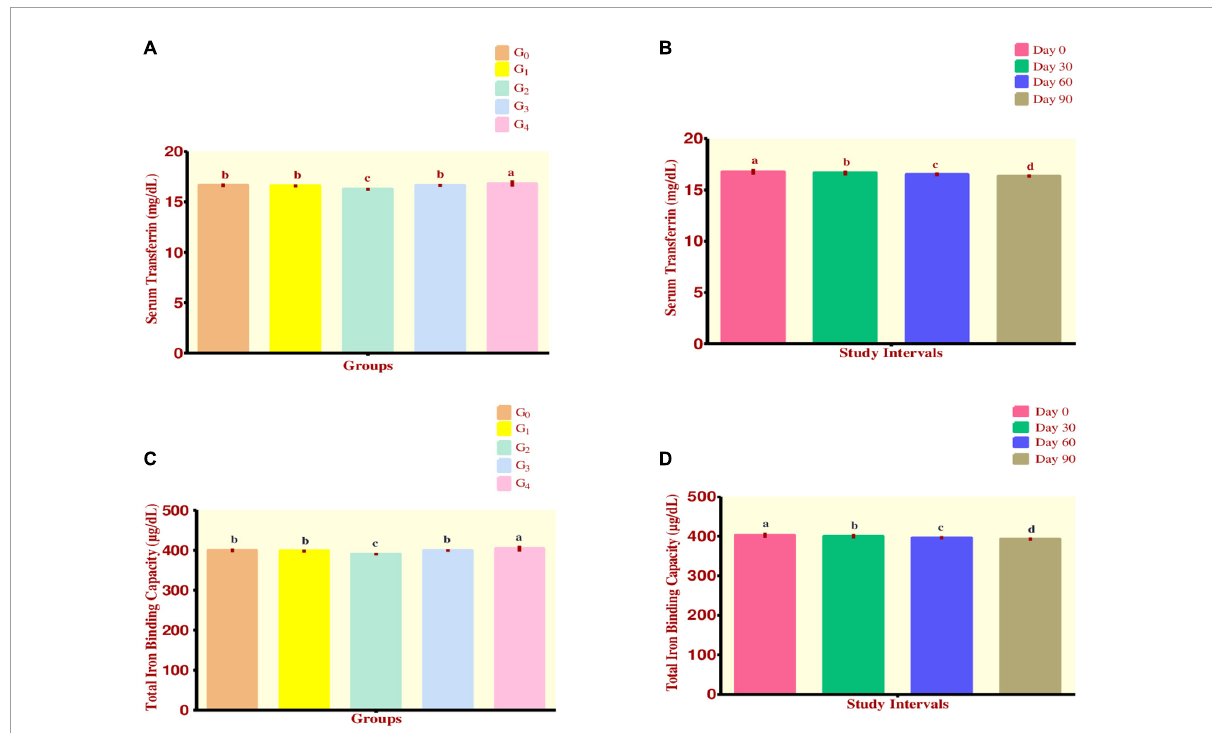
FIGURE3 (A–D) Effect of fortified diets on serum transferrin and TIBC among anemic women data are presented as Means ± SD . P -value < 0.05 is considered to be significant. Means carrying the same letters are not significantly